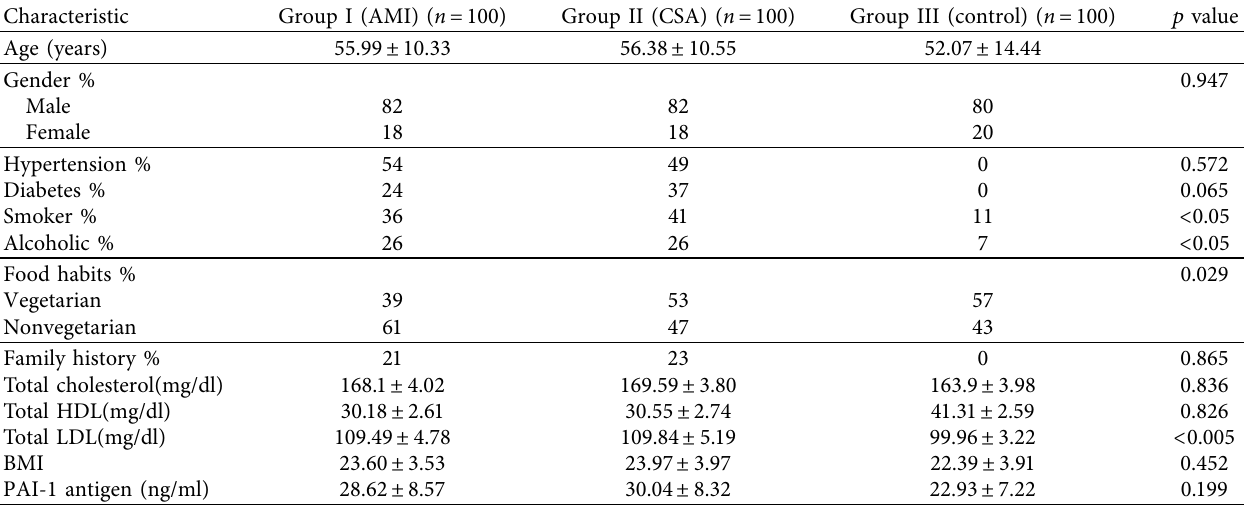
Table 1: Clinical characteristics of patients and controls.